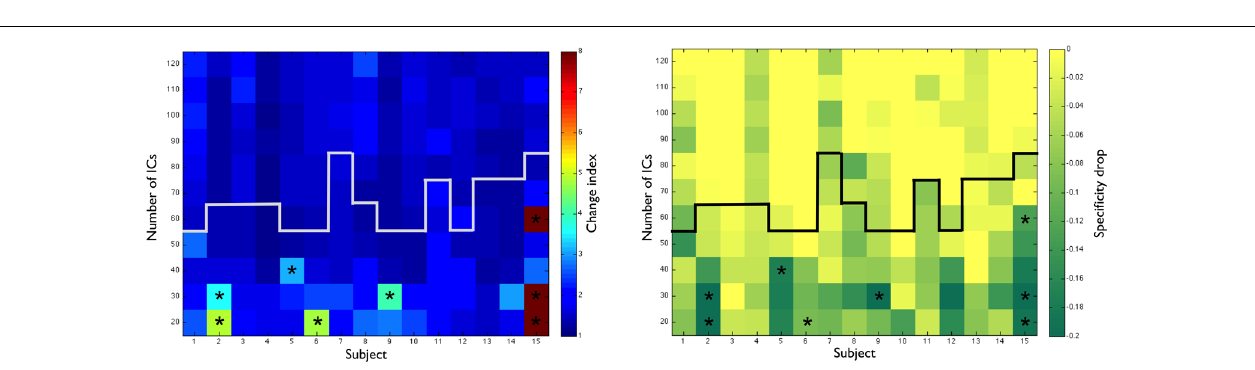
FIGURE 5 | (Upper panel) Dice coefficient averages at different thresholds ( z = 2 to z = 6) between rs-fMRI and task-fMRI (left) , and between rs-fMRI and taskIC-fMRI (right) . Colors represent the average Dice coefficient for all subjects at each threshold. (Lower panel) Specificity (left) and sensitivity (right) for rs-fMRI, taskIC-fMRI and task-fMRI at different thresholds (from z = 2 to z = 6). Vertical bars denote standard errors of the mean.